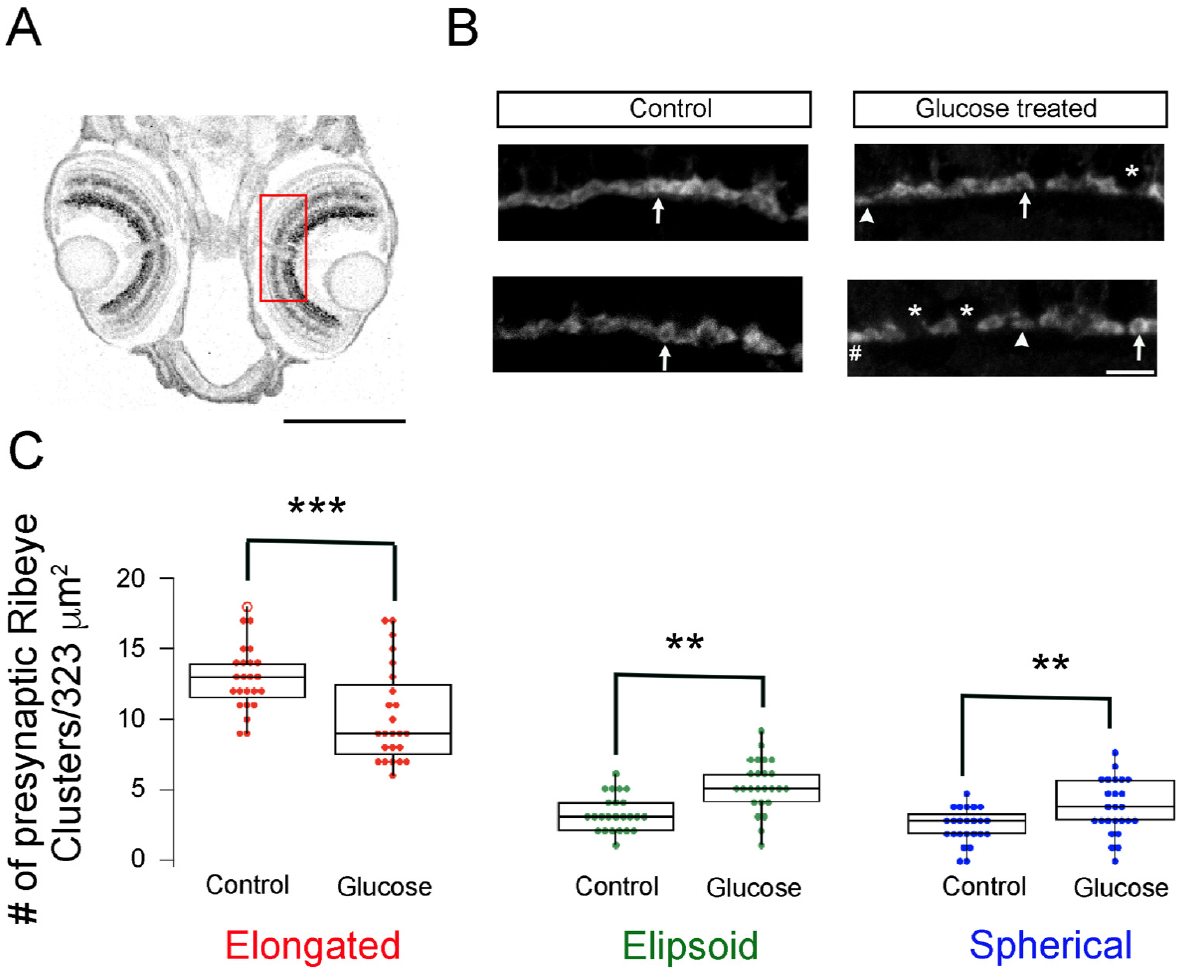
Figure 2. The maturation of synaptic ribbons is delayed in hyperglycemic zebrafish larvae. ( A ) Imaging region of the retina is illustrated with a ROI (red) placed on the transverse section of 5 dpf larvae. Scale bar, 200 µ m; ( B ) Maximal intensity projection of confocal z-stacks of retinal sections from control ( left panels ) and hyperglycemic larvae ( right panels ) immunostained with fluorescently labeled antibodies specific for ribeye/CtBP2. Mature (elongated, arrow) and immature (ellipsoid, arrowhead or spherical, #) ribbon morphologies are indicated. * Denotes the gaps between ribbons. Scale bar, 5 µ m; ( C ) Quantitative analyses of ribbon morphologies in retinal sections stained for ribeye/CtBP2 were categorized according to morphology, as described in Materials and Methods: mature (elongated, red) and immature (ellipsoid, green or spherical, blue) morphologies were noted and are shown as box-and-whisker plots. Boxes show all values, while whiskers indicate minimum and maximum values. Data are presented as mean values ± SEM. The total number of profiles examined was 521 control larvae and 388 glucose-treated larvae in groups of 50 larvae; the retinas from each of the larvae were processed independently. ** p < 0.01; *** p < 0.001. Abbreviations: CtBP2, C-terminal binding protein 2; dpf, days post-fertilization; ROI, region of interest; SEM, standard error of the mean.